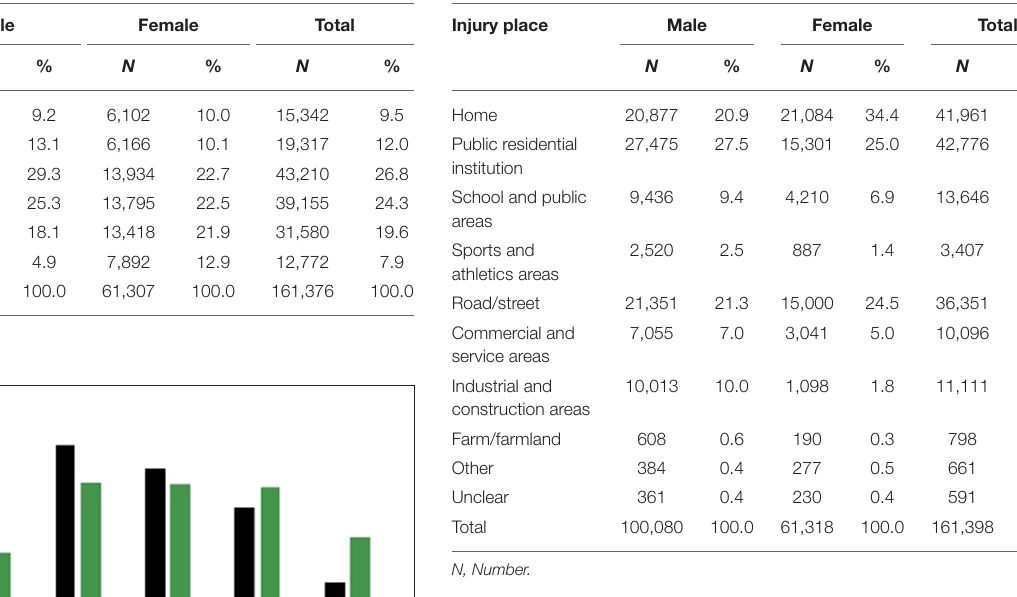
TABLE 1 | Injury cases by age group and gender.